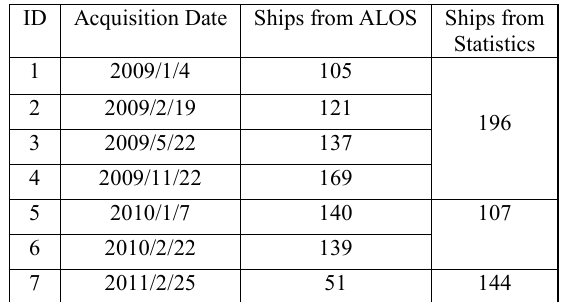
Table 4. Total number of recycling ships analysis by